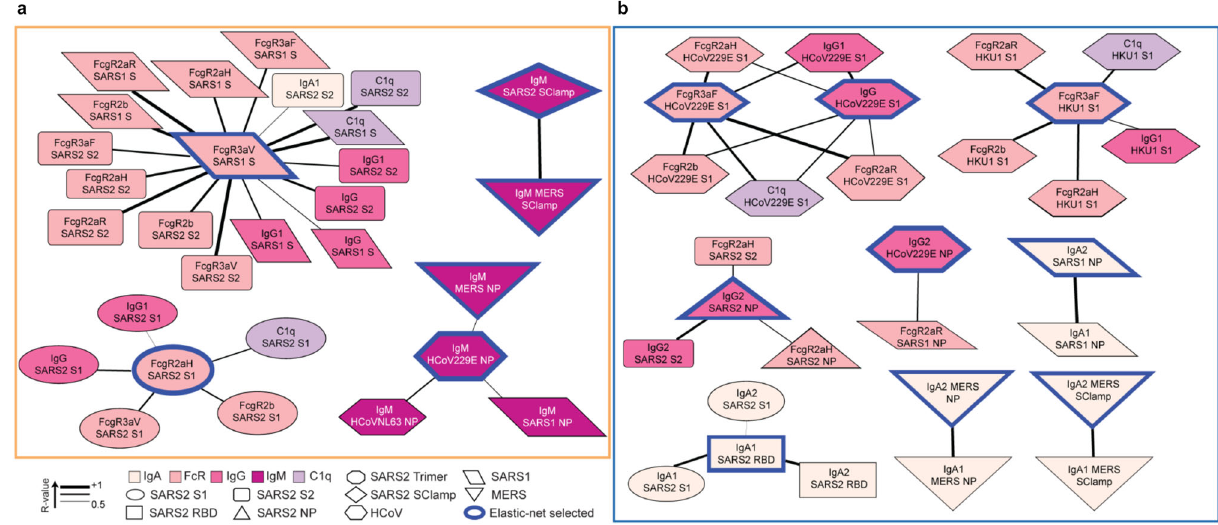
Fig. 3 Healthy children and elderly have differing correlation networks. Correlation network analyses for healthy children ( a ) and elderly ( b ) identify features associated with the Elastic-Net-selected features (blue outline). Coded by Ab feature type (colour), antigen (shape) and correlation coef fi cient (line (FcgR2b), C1q and binding to Fc γ RIIIa-V158 (the higher af fi nity